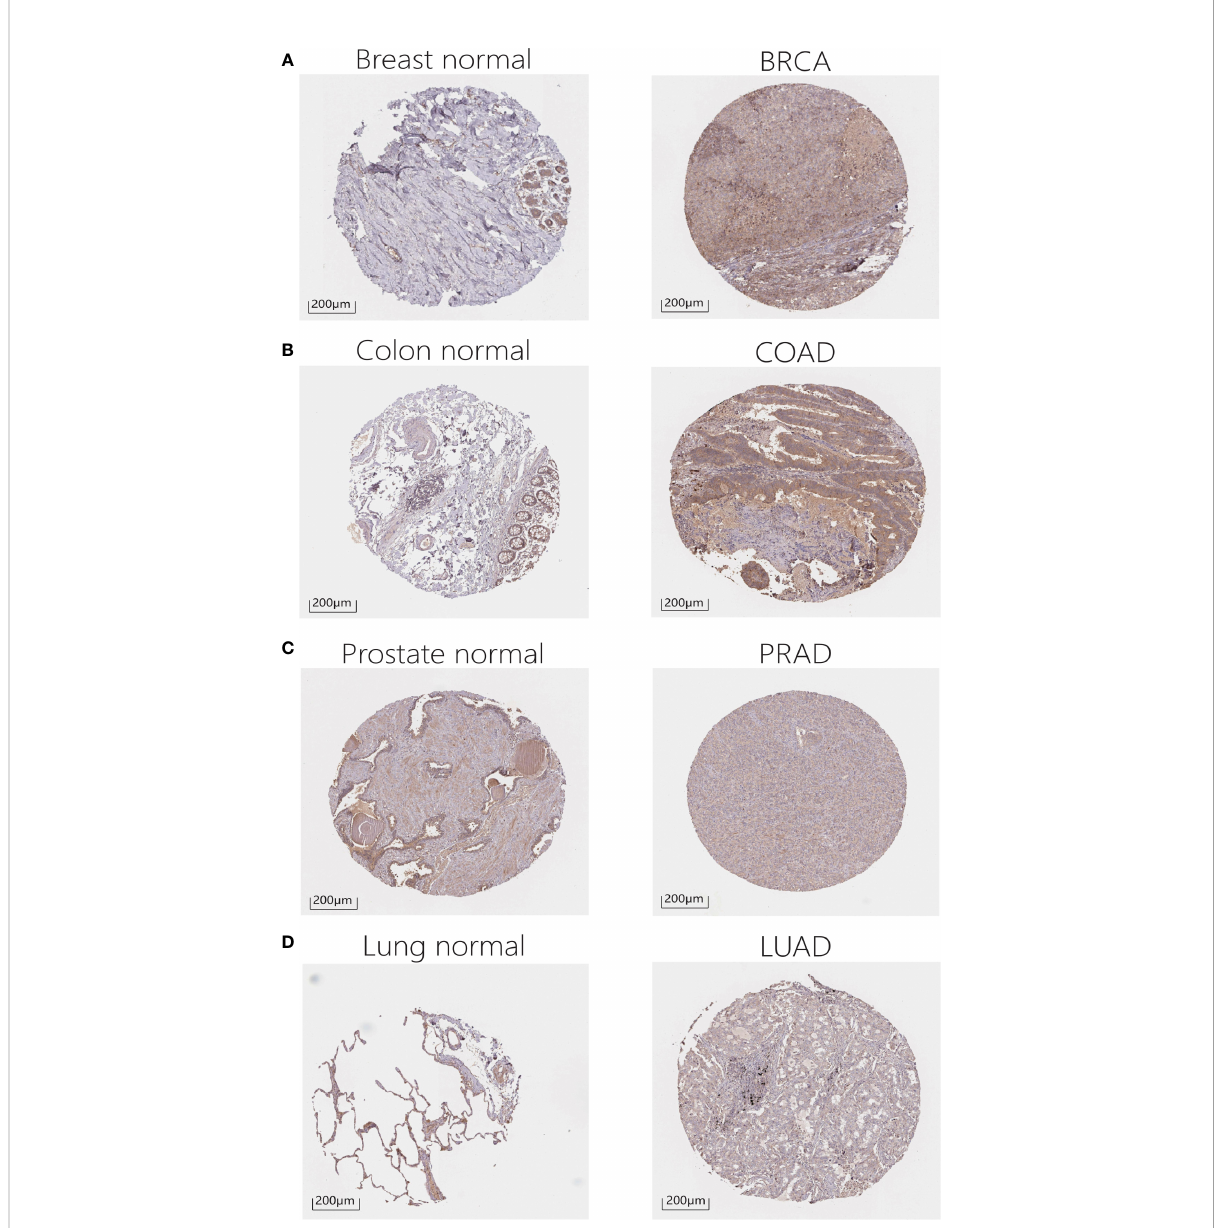
FIGURE 2 IHC results for RALA expression levels in cancers and normal tissues. (A) Breast. (B) Colon. (C) Prostate. (D)